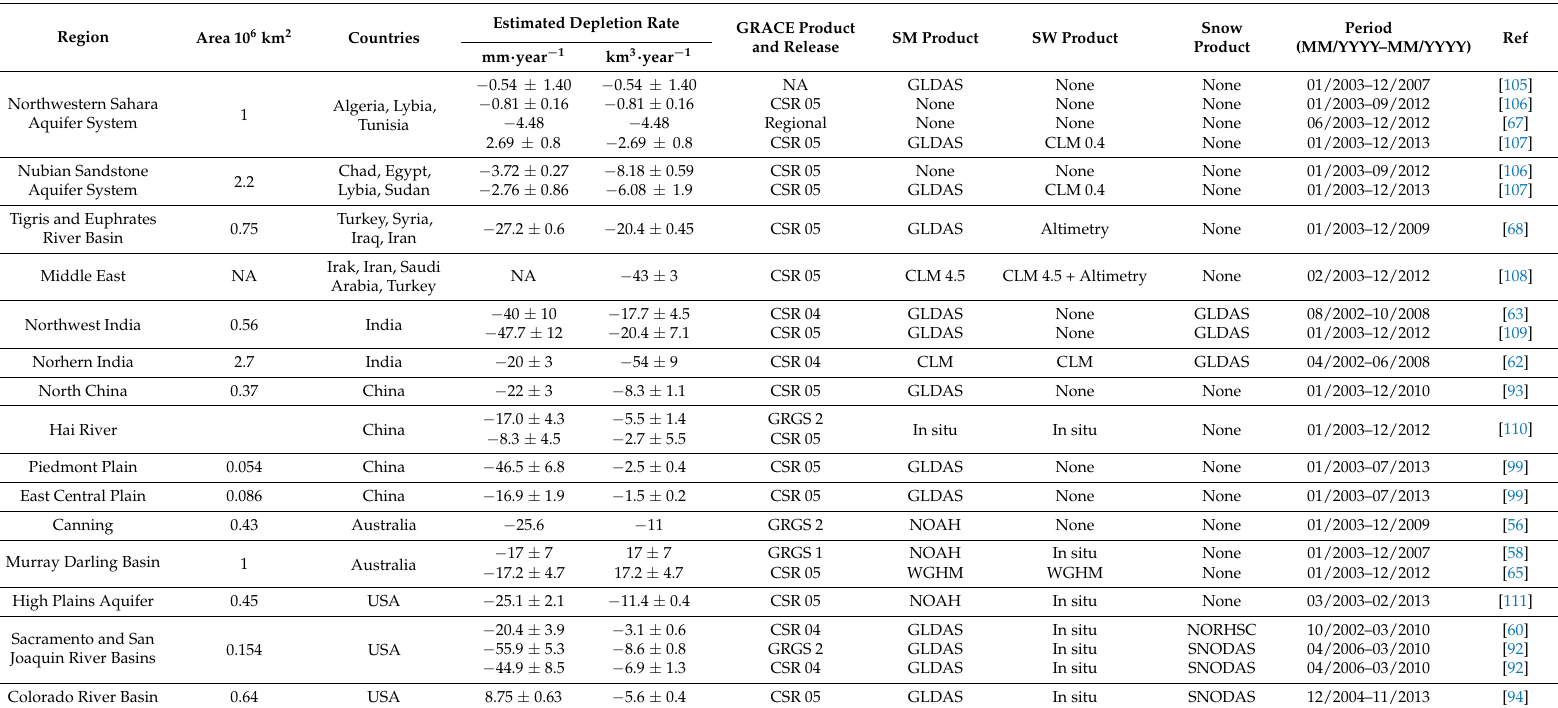
Table 1. Annual rates of groundwater depletion in the major aquifers located in arid and semi-arid regions based on the decomposition of GRACE-based